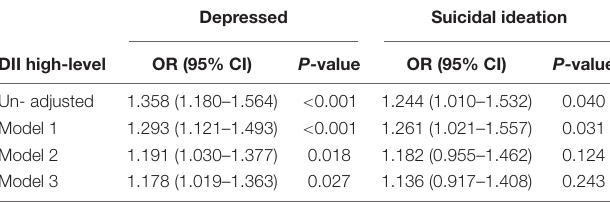
TABLE 2 | Multi-factor logistic regression analysis for associations DII high-level and